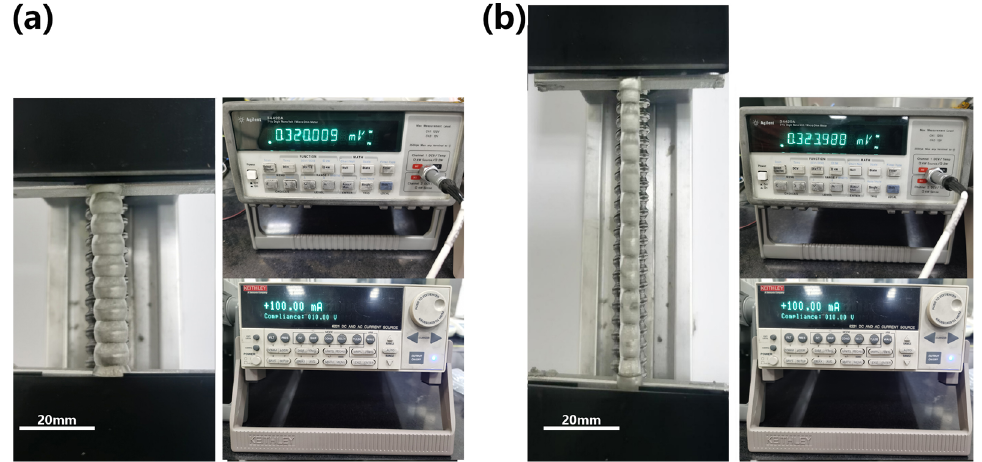
Figure 6. ( a ) Voltage of the initial state of stretchable conductor at 100 mA. ( b ) Voltage of 50% tensile strain of stretchable conductor at 100 mA.